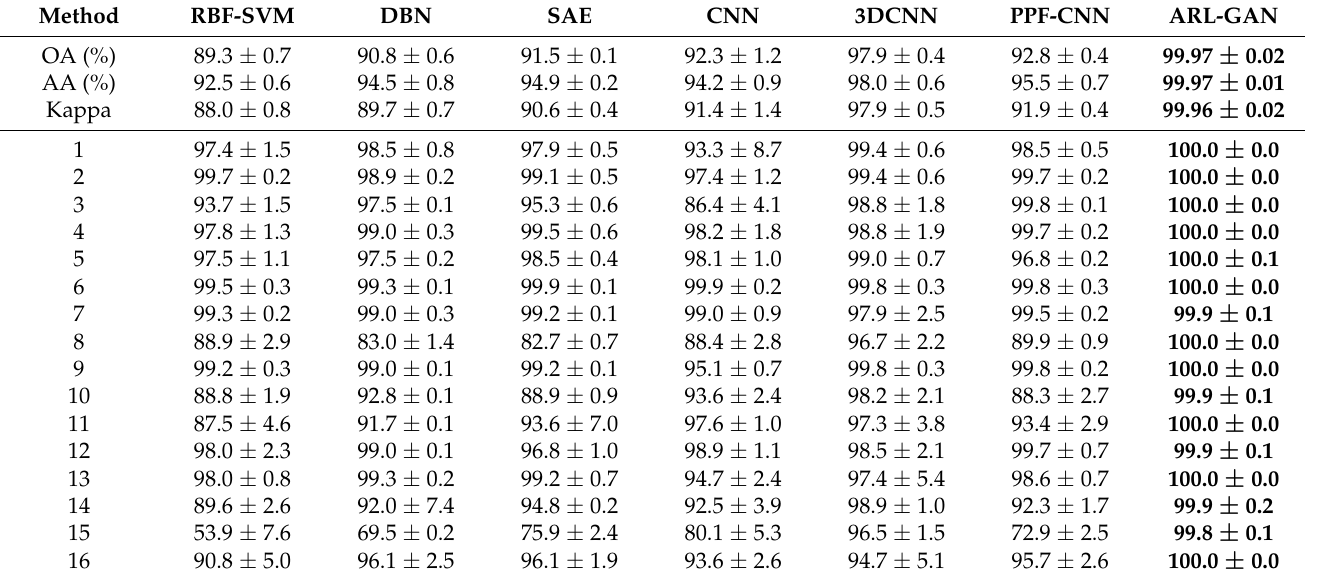
Salinas: The classification results of the Salinas dataset are shown in Table 6. Firstly,